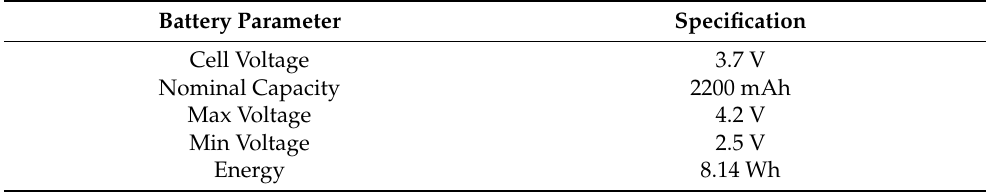
Table 1. Battery specification of A18650 model of Hongli Li-ion battery.